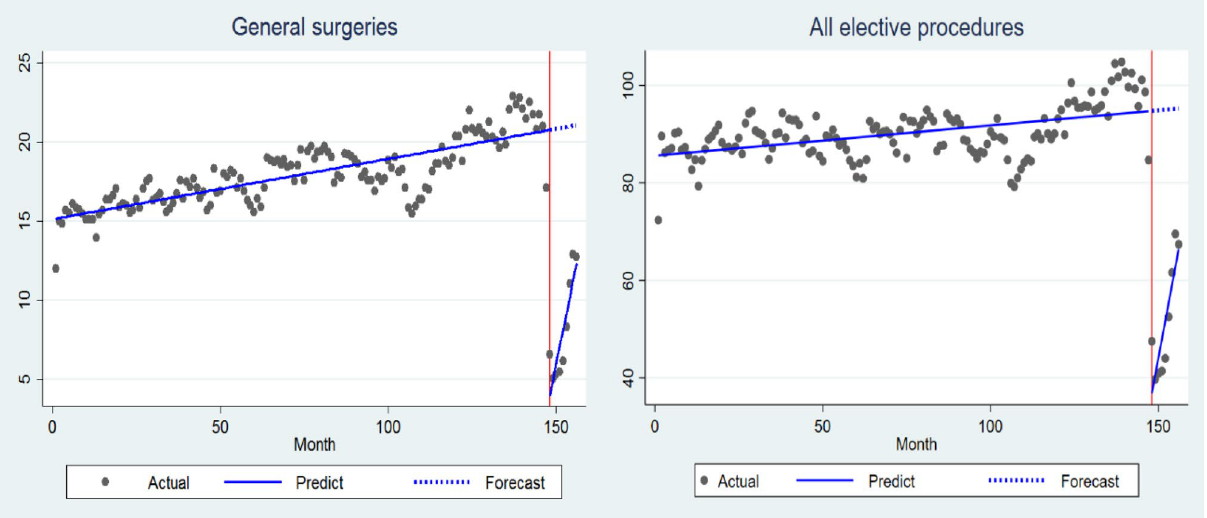
Figure 1. Graphical representation of the effect of COVID-19 pandemic on hospital rate for elective procedures (general surgeries and all elective procedures) from interrupted time series regression in Brazil,